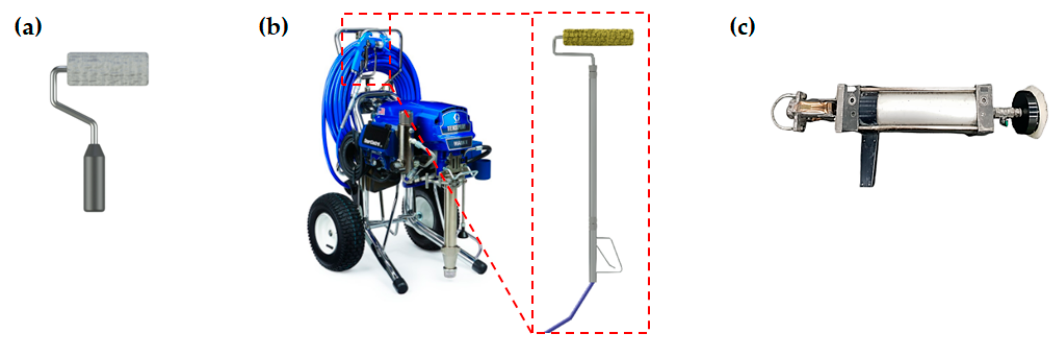
Figure 2. Selected coating equipment: ( a ) control, ( b ) E1, and ( c ) E2.